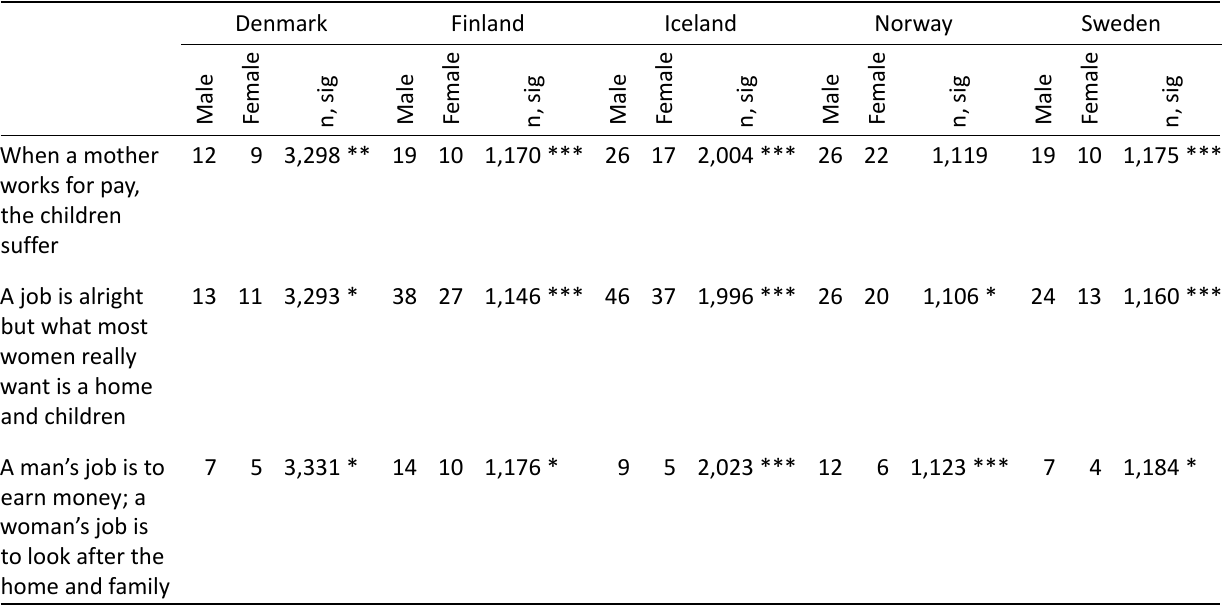
Table 2. Attitudes toward gender and care, percentage agreeing to the three items among men and women (all age groups, Nordic countries, 2017).